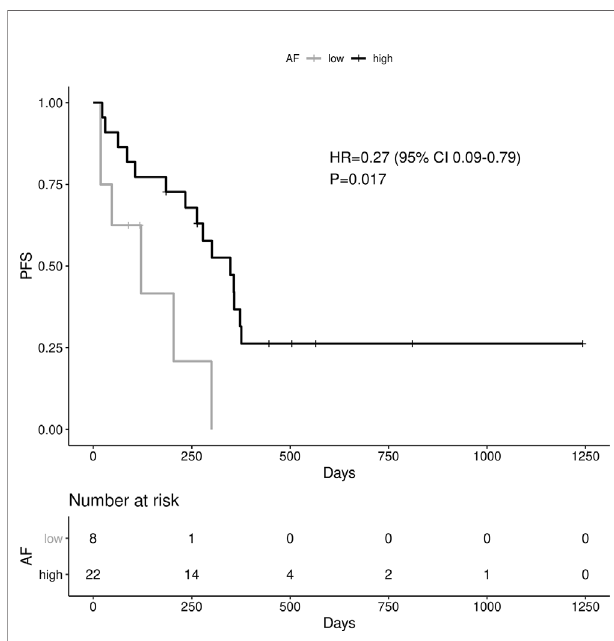
FIGURE 1 | Impact of EGFR allele frequency on